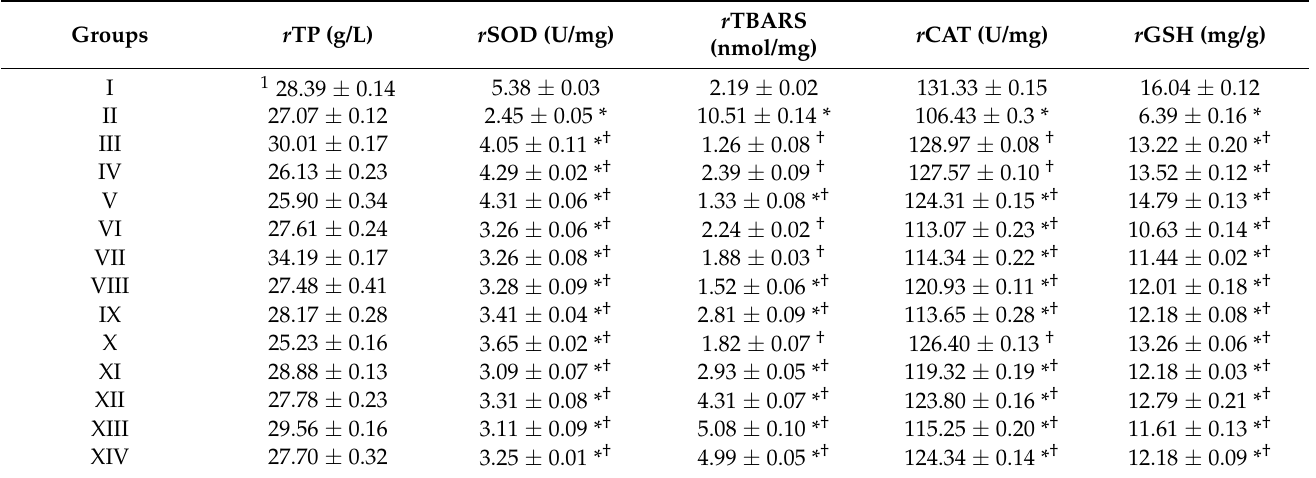
Table 2. Total protein content ( r TP), catalytic activities, and concentrations of liver antioxidant enzymes in rats exposed to different doses of N. cataria extracts and CCl 4 .